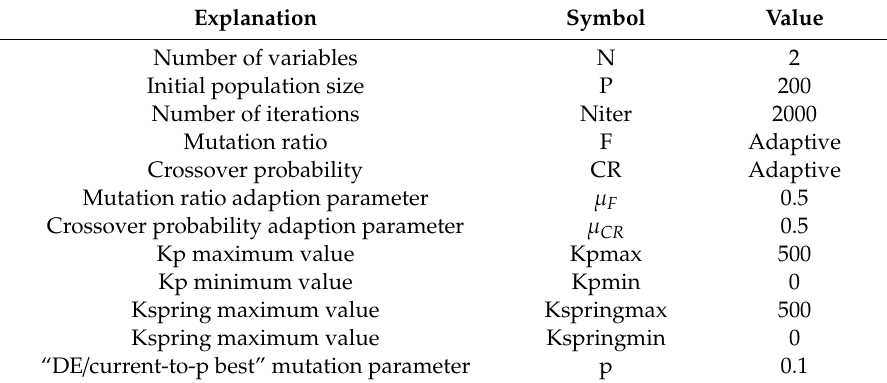
Table 3. Configuration parameters of the adaptive di ff erential evolution (JADE) algorithm.